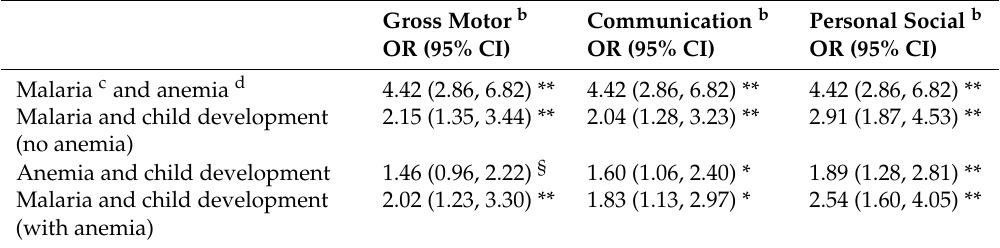
a Table includes mediation test results of four regressions evaluating the association between: 1) malaria and anemia, 2) malaria and child development outcome (without anemia), 3) anemia and child development outcome, and 4) malaria and child development outcome (with anemia). b Risk for developmental delay defined as having a Z-score below the 25th percentile control group Z-score. c Binary, 1 = positive RDT. d Binary, 1 = anemic (Hb < 11.0 g / dL).